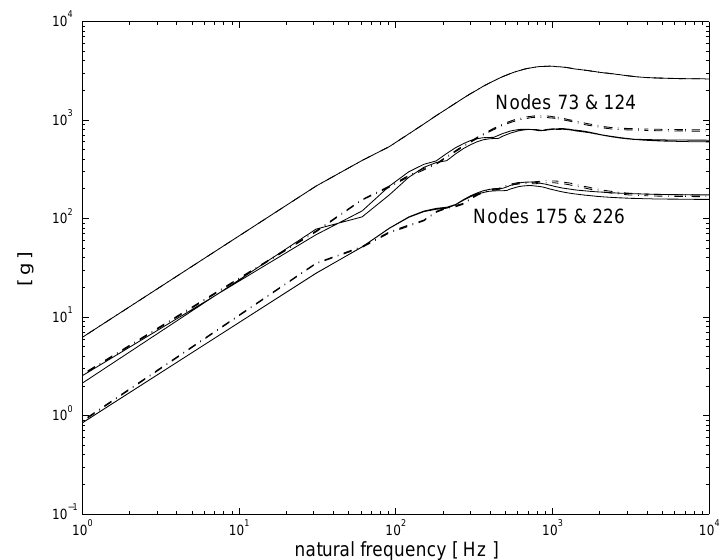
Fig. 7. SRS predicted by MSC-NASTRAN (continuous line) and by wave propagation analysis (dashed line) at several nodes. t = y sin θ − z cos θ 1 j j j j j t = y cos θ + z sin θ 2 j j j j